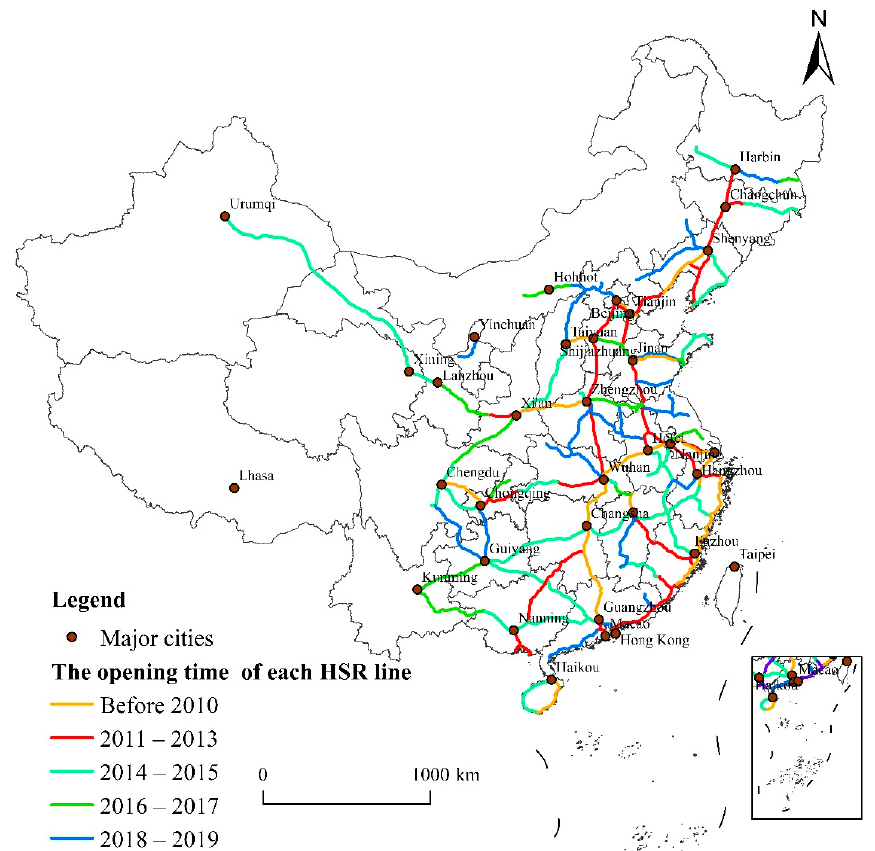
Figure 1. HSR network in China (2019).